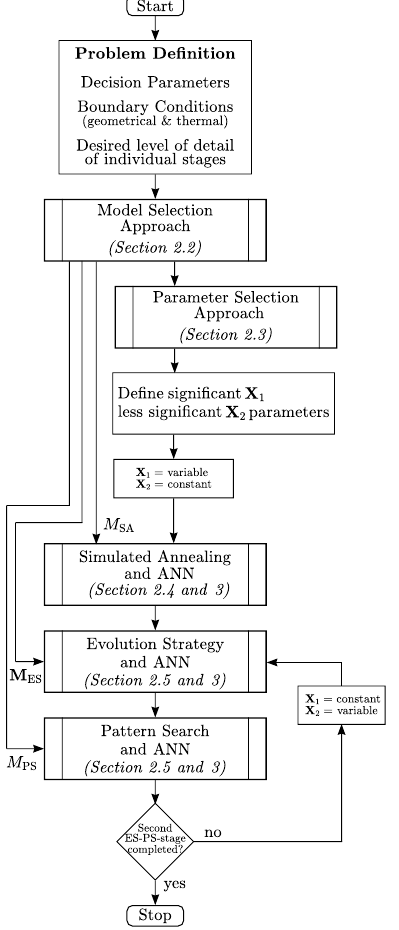
Figure 1. Flow chart of the multi-stage optimization